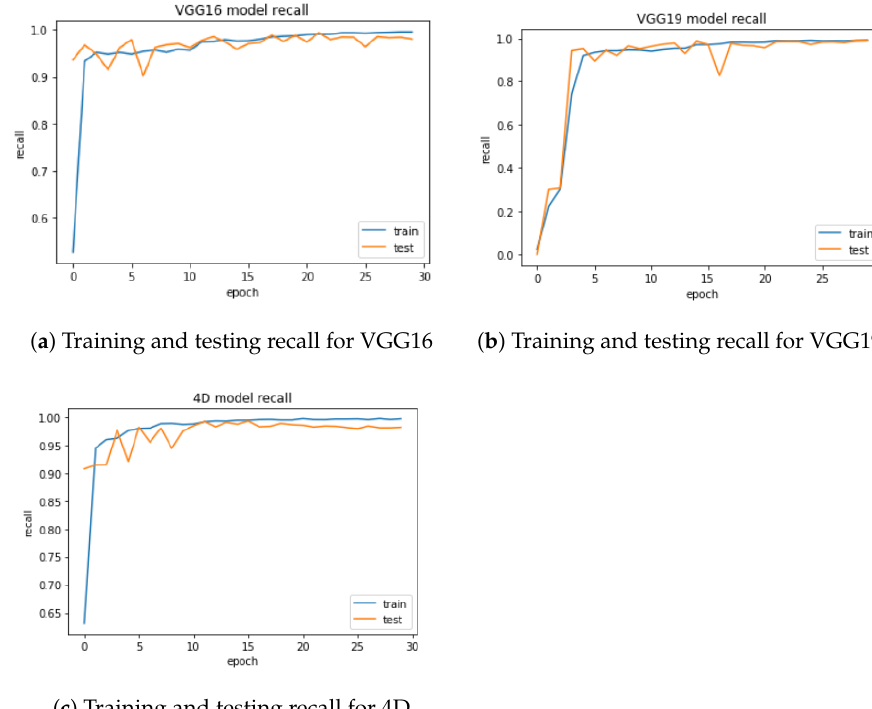
Figure 11. Training and testing recall curves for different